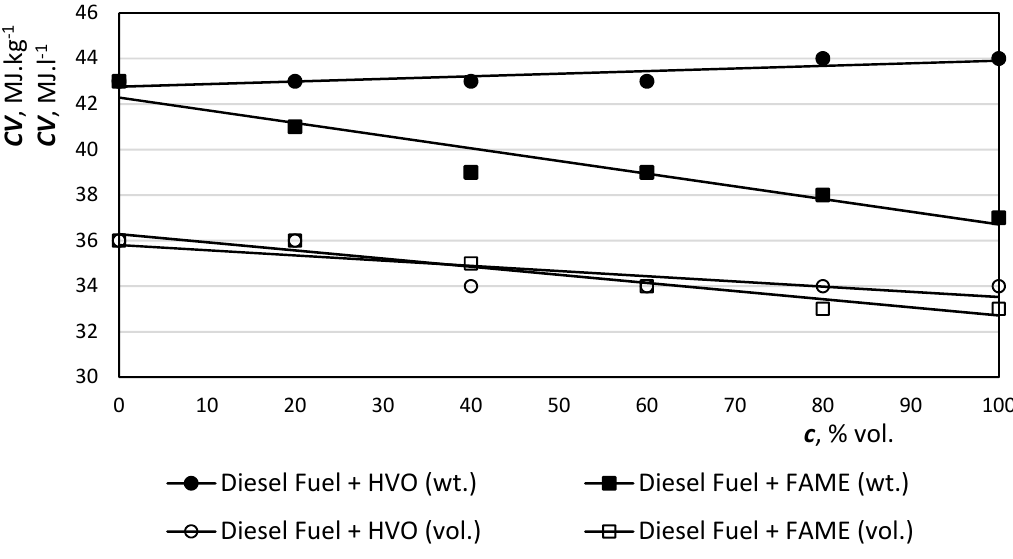
Figure 5. Calorific value of mixed fuels.